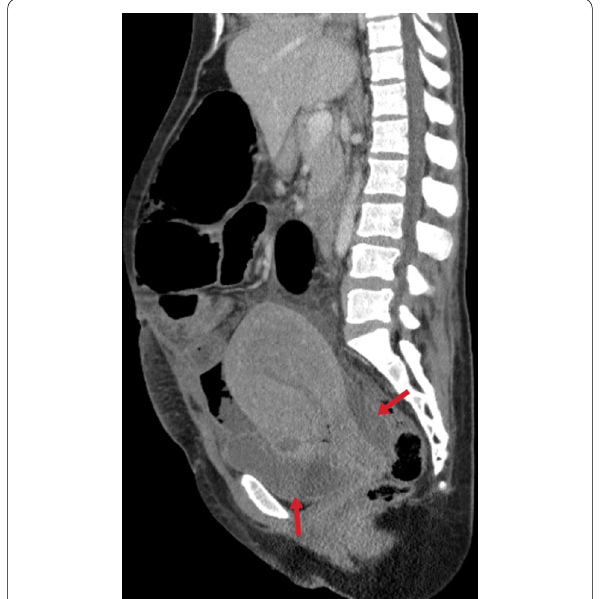
Fig. 43 Sagittal-reformatted abdomen CT image of a 22-year-old female with lower abdominal pain and fever obtained after C/S surgery. The uterus is enlarged due to prior pregnancy. Free fluid is noted in the pelvis (arrows). Tuberculous pelvic inflammatory disease